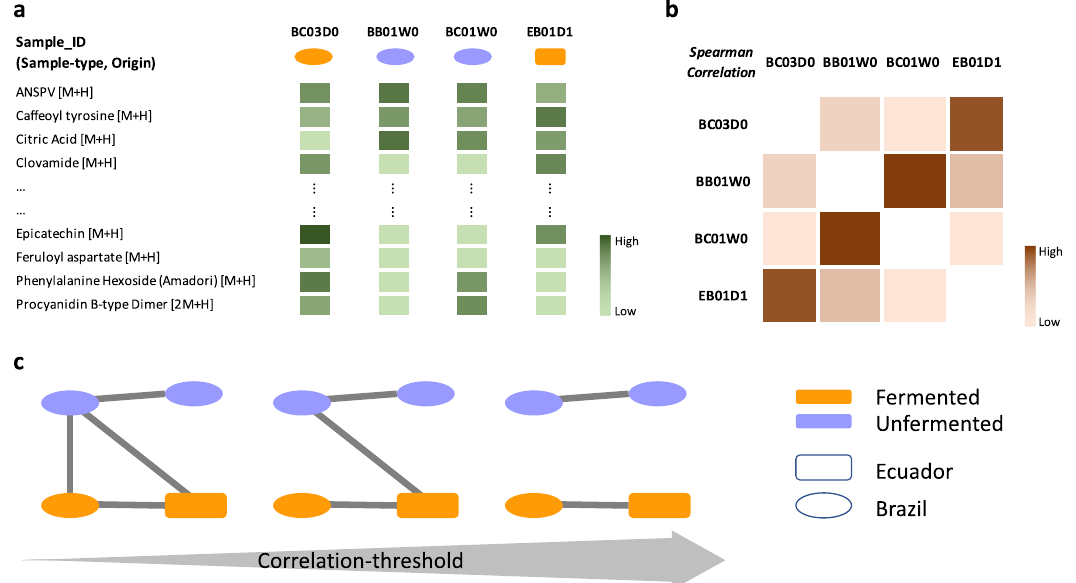
Fig. 1 Schematic illustration of working procedure. ( a ) Schematic of LC-MS data structure. Subset of real LC-MS dataset (compounds in rows, samples in columns): the darker the color of a box, the higher the concentration of the compound in the sample. In this schematic illustration a couple of samples from Ecuador and Brazil of unfermented and fermented categories are shown. ( b ) Schematic representation of correlation matrix. Spearman correlation between different samples. ( c ) Schematic of network generation. Correlation networks as a function of increasing correlation thresholds. An edge exists between two nodes only when the correlation between them is greater than or equal to some speci fi ed